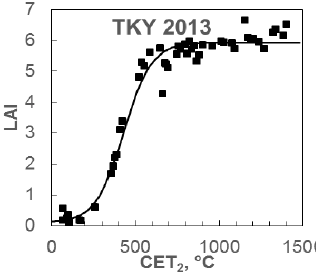
Figure 2. LAI of forest canopy as a function of cumulative effective temperature >2 °C (CET 2 ) during the leaf expansion period of 2013 at TKY. The line represents the model, and squares are estimated LAI values. LAI